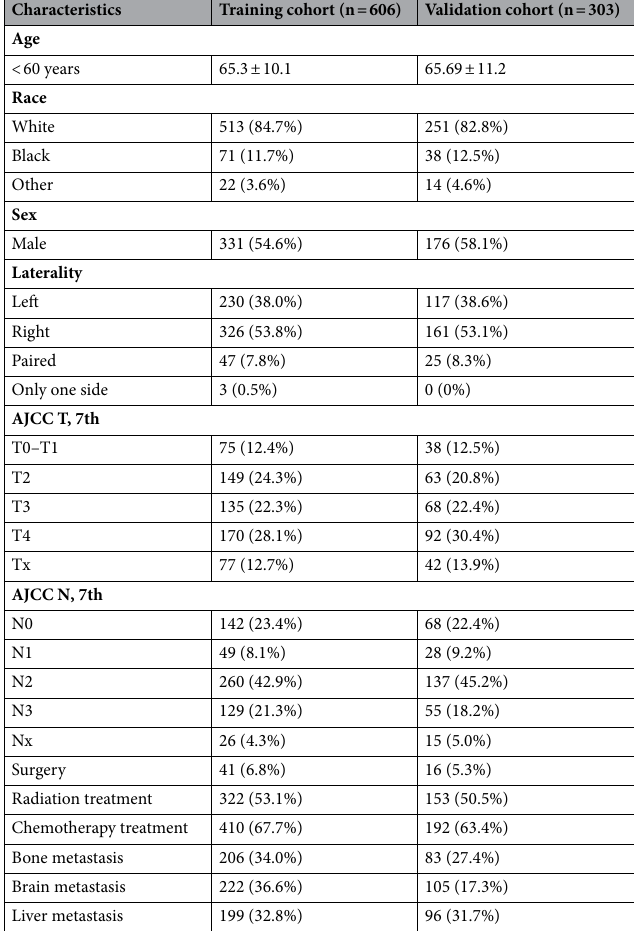
Table 1. The population general conditions of the training set and validation